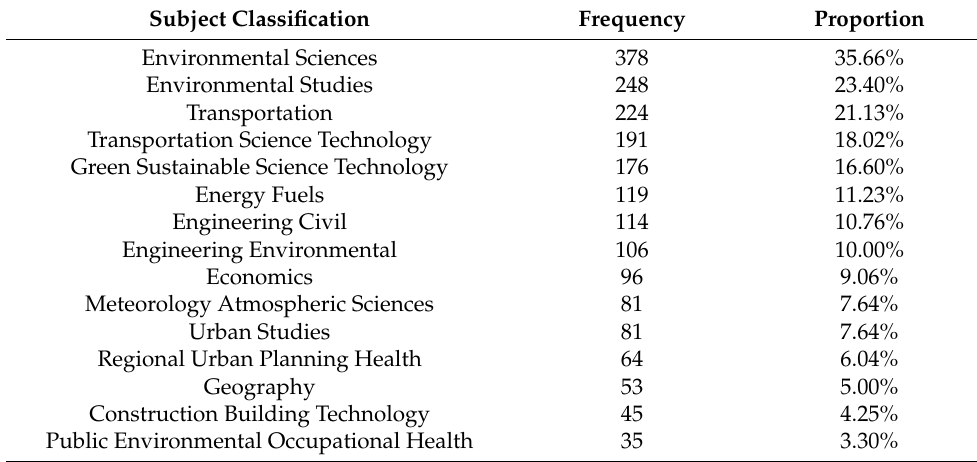
Table 1. Subject classifications from WOS and their